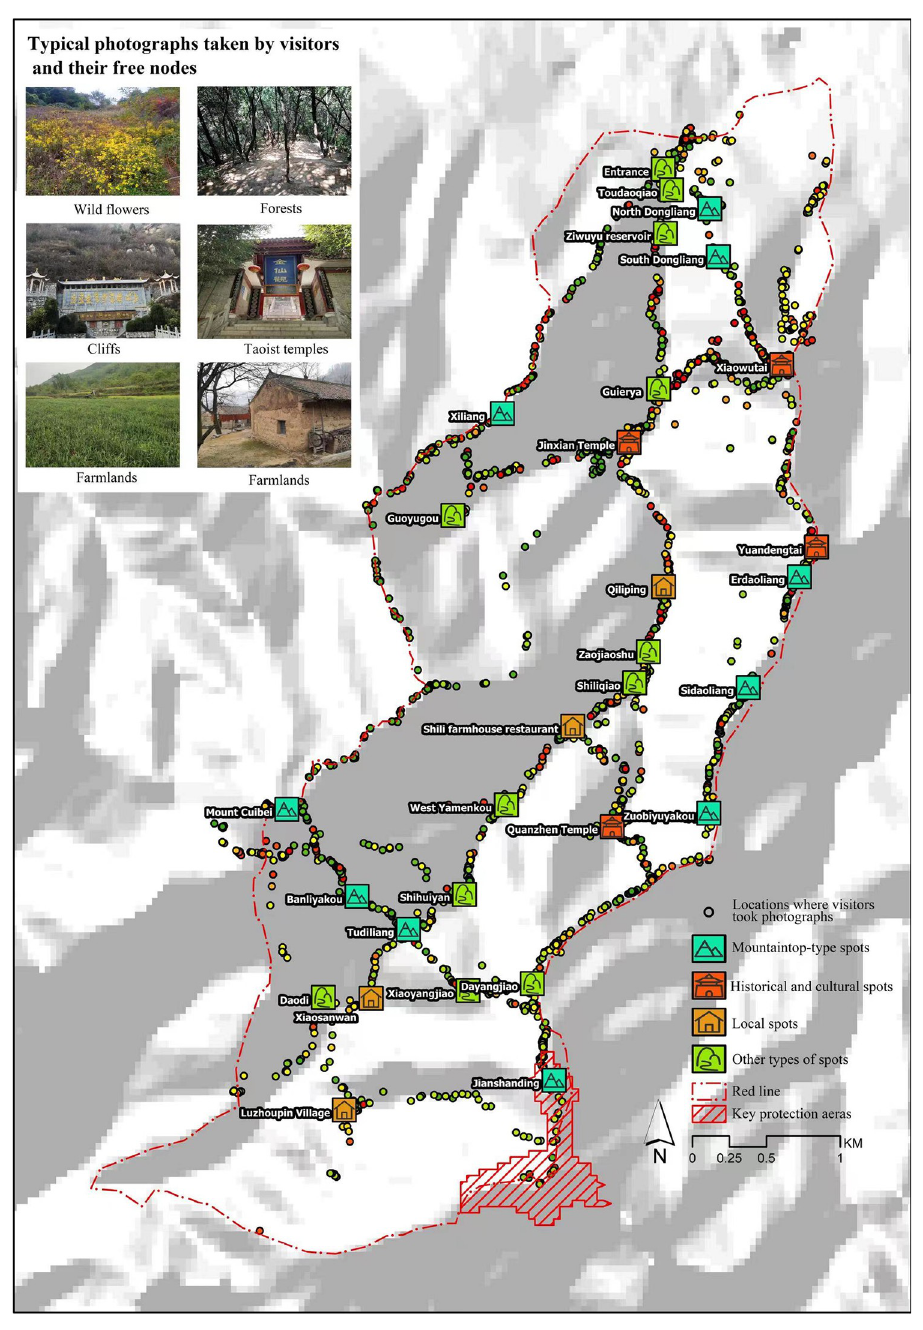
Fig 1. Geotagged photographs and codes. Reprinted from [https://www.usgs.gov/centers/eros/data] under a CC BY license, with permission from [United States Geological Survey], original copyright [2000]. Reprinted from [https:// www.2bulu.com/] under a CC BY license, with permission from [Shenzhen Bubulu Information Technology Co., Ltd.], original copyright